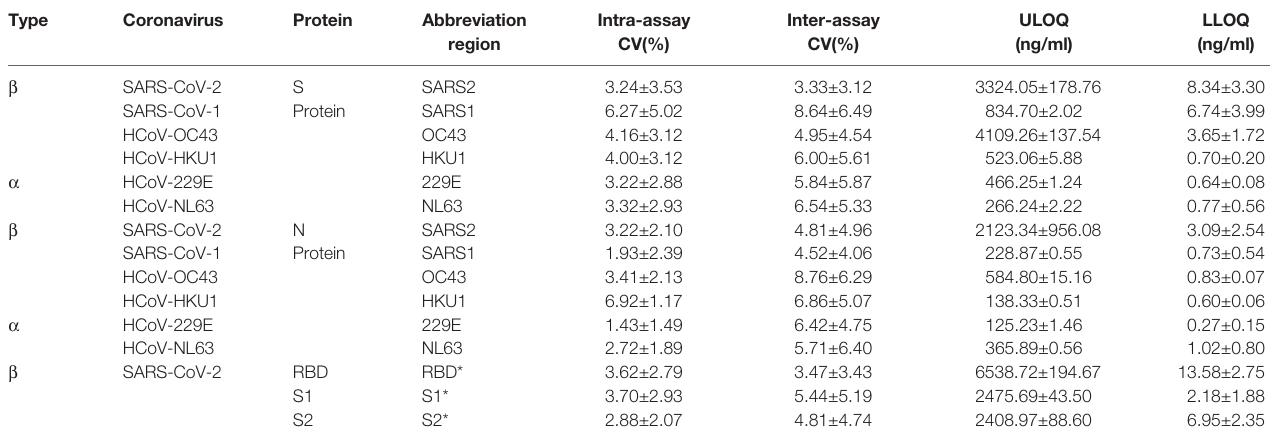
TABLE 2 | The mPlex-CoV assay panel of human